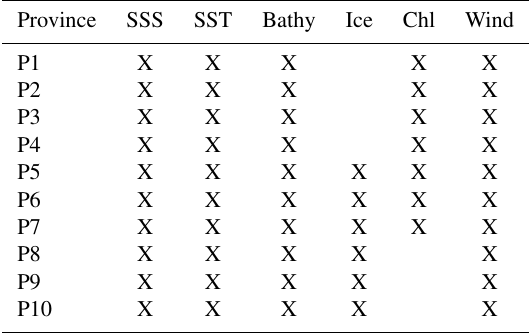
Table 2. List of the biogeochemical provinces, their geographic distribution and the environmental predictors used to calculate sur- face ocean p CO 2 . SSS stands for sea-surface salinity, SST for sea- surface temperature, Bathy for bathymetry, Ice for sea-ice cover, Chl for chlorophyll concentration and Wind for wind